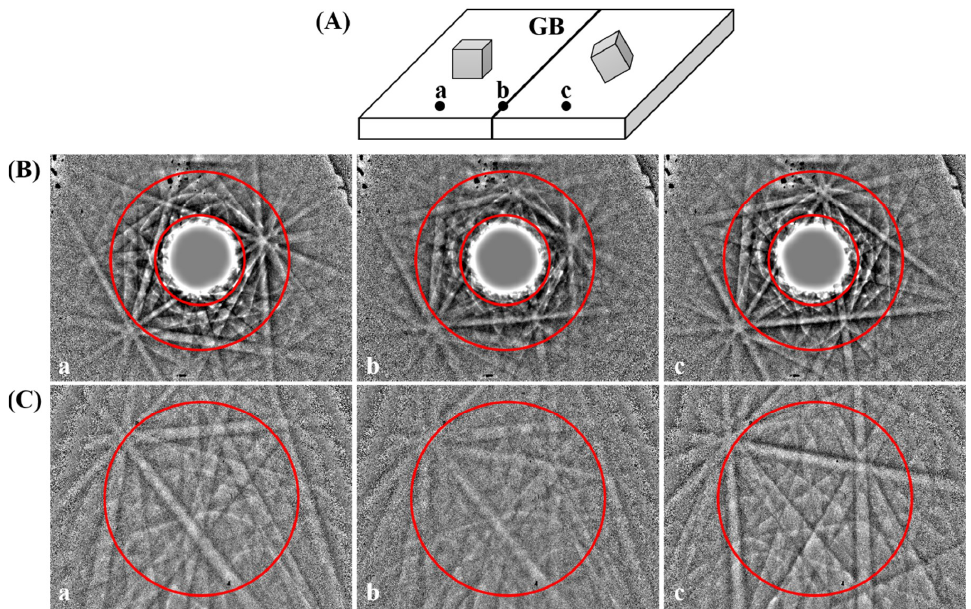
Figure 1. ( A ) Schematic of the ferritic steel lamella used for the determination of the spatial resolutions of the on-axis and off-axis transmission Kikuchi diffraction (TKD). Kikuchi patterns across the grain boundary at an accelerating voltage of 30 kV and thickness of 91 nm, acquired by ( B ) on-axis TKD (the regions of interest (ROIs) are outlined by the red annular rings) and ( C ) off-axis TKD (the ROIs are outlined by the red circles).